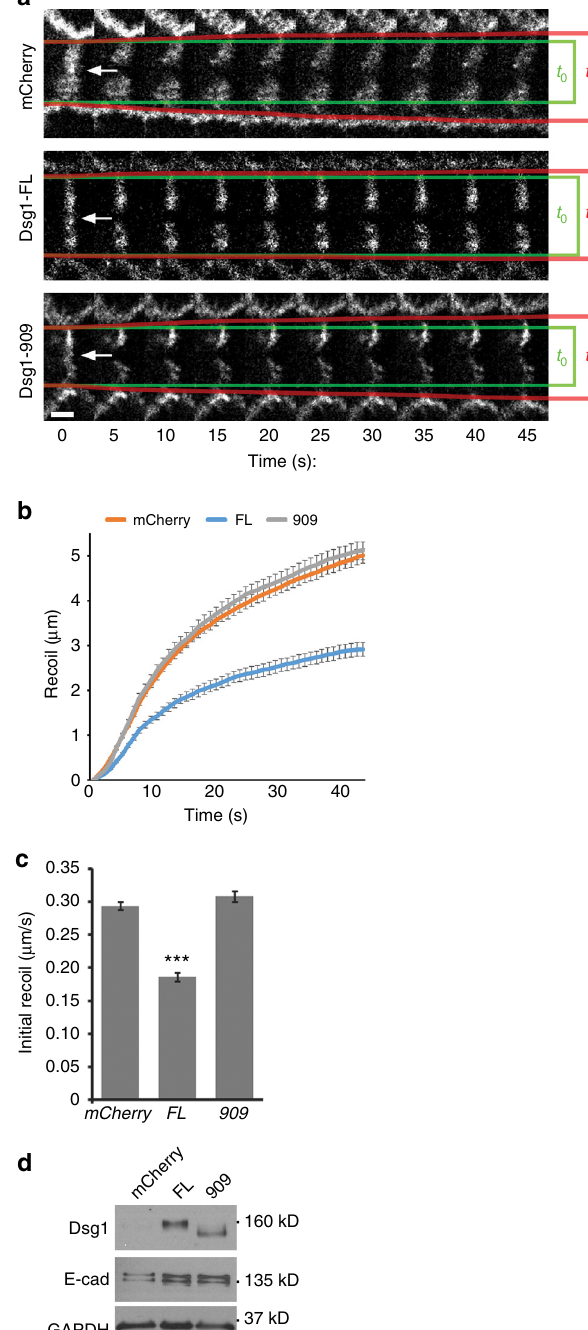
Fig. 6 Position of Dsg1 at the cell – cell interface regulates cortical tension in keratinocytes. a Representative confocal images before and after ablation in NHEKs with mCherry, Dsg1-FL-Flag, or Dsg1-909-Flag. Scale bar = 5 μ m. b Exponential curves of junctional recoil. c Quanti fi cation of tension (initial recoil) following ablation in NHEKs with mCherry, Dsg1-FL-Flag, or Dsg1- 909-Flag (three independent experiments; F = 110.5, *** p < 0.001 one-way Anova with Tukey test). d Western blot of undifferentiated NHEKs retrovirally transduced with E-cad-YFP together with mCherry, Dsg1-FL- Flag, or Dsg1-909-Flag used for laser ablation. GAPDH is a loading control. Error bars represent